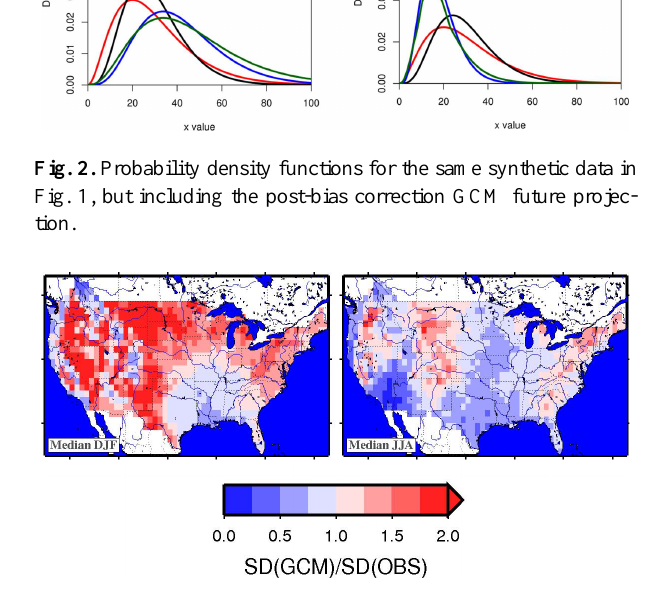
Fig. 3. Ensemble median of the ratio of the standard deviation (SD) for the GCMs to the SD of the observations for daily precipitation during DJF and JJA for